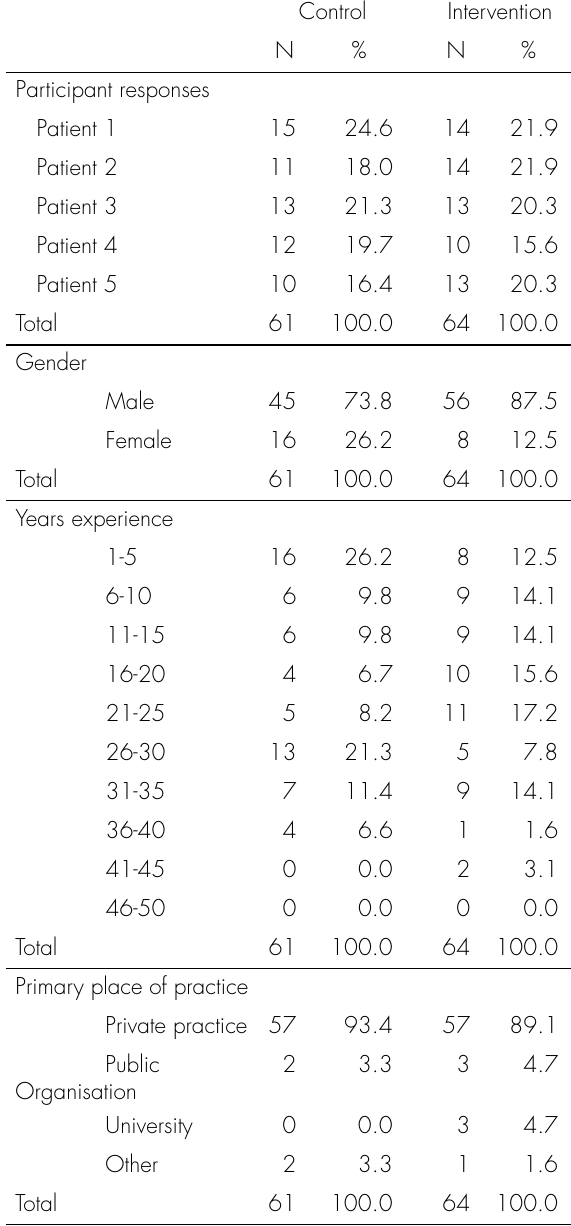
Table II. Descriptive statistics of participating orthodontists. the intervention group. The test statistic used